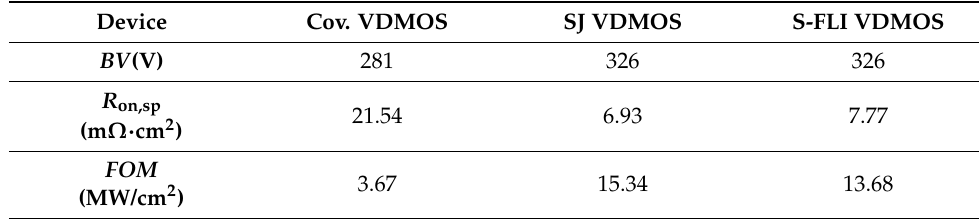
L D is the length of N-drift region. N D is the concentration of N-drift region. N SUB is the concentration of P-substrate. N P is the concentration of P-base region. Rings is the number of rings, in which a ring consists of two Step Floating Islands at the same Y coordinate. Table 2. Simulation results for the Cov. VDMOS, SJ VDMOS and S-FLI VDMOS.